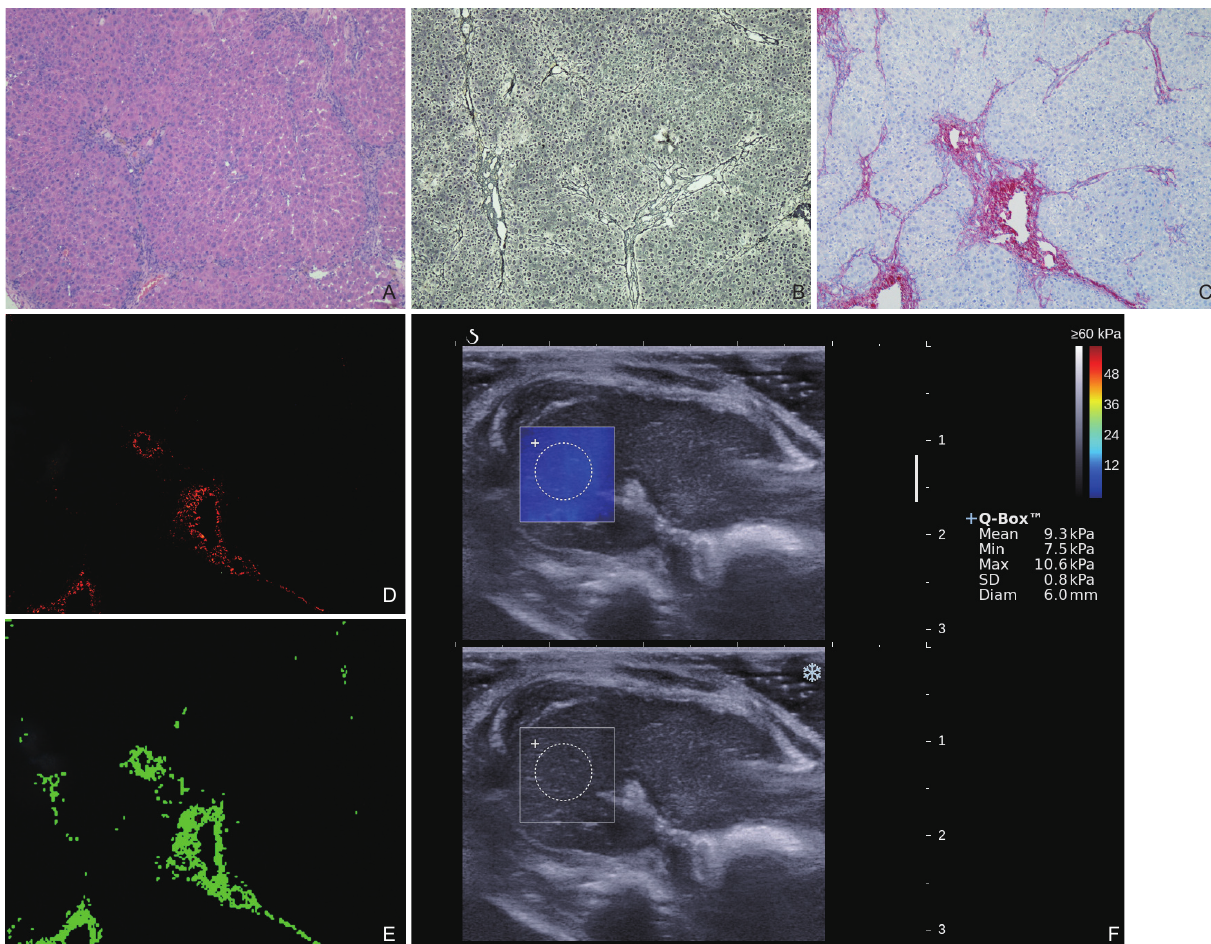
Figure 5 Images of a histologically proven stage 3 rat ‘b’. Scheuer staging observed by HE staining (A) and reticular fiber staining (B). Collagen proportionate area (CPA) of 1.708 measured by the picric-sirius red staining (C), polarized imaging (D), and digital images (E). Liver stiffness of 9.3 kPa was shown in an elastogram